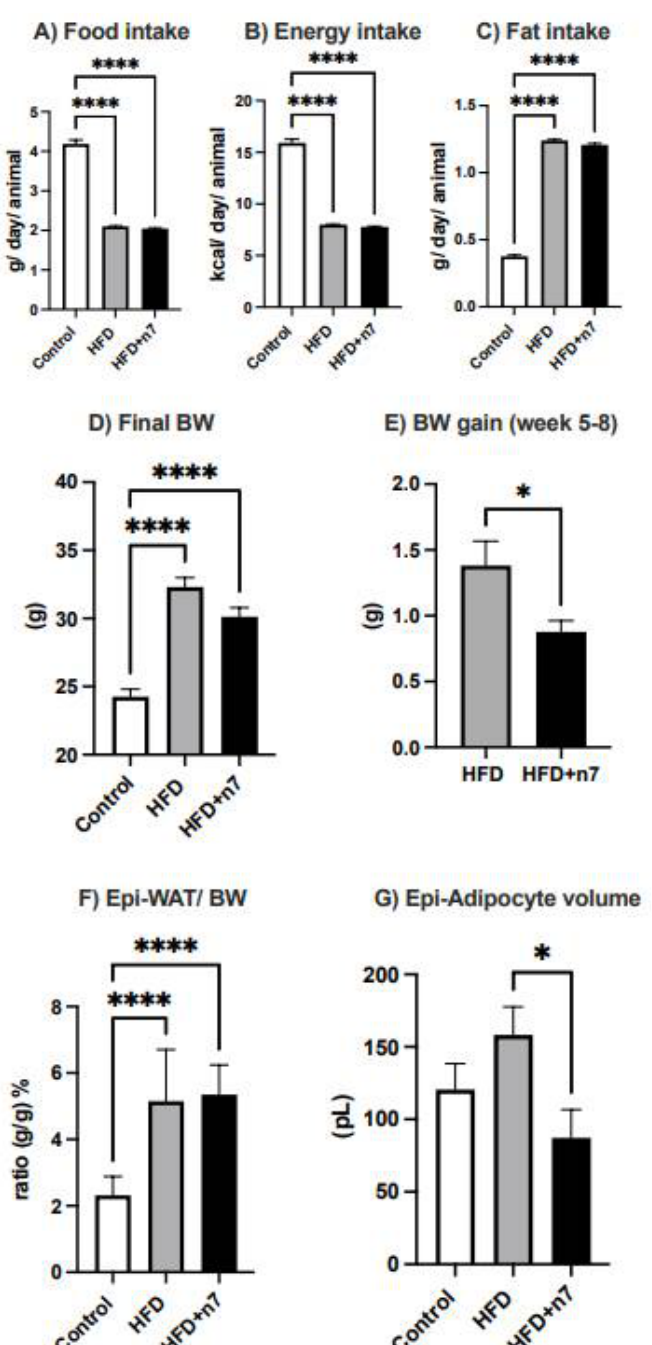
Figure 1. Effects of high fat diet (HFD) and palmitoleic acid (N7) supplementation on food consumption, body weight gain, adiposity and hypertrophy of mice adipocytes. Food ( A ), energy ( B ), and fat ( C ) intake. At the weeks 5–8, the diets were maintained and mice received water (control and HFD groups) or palmitoleic acid (HFD+n7 group) by oral gavage. Final body weight (BW) ( D ), BW gain during weeks 5 to 8 ( E ), relative epididymal (Epi)-WAT mass per BW ( F ) and Epi-adipocytes volume ( G ). Values are mean ± SEM (n = 12). * p < 0.05 or **** p < 0.0001 vs. Control.